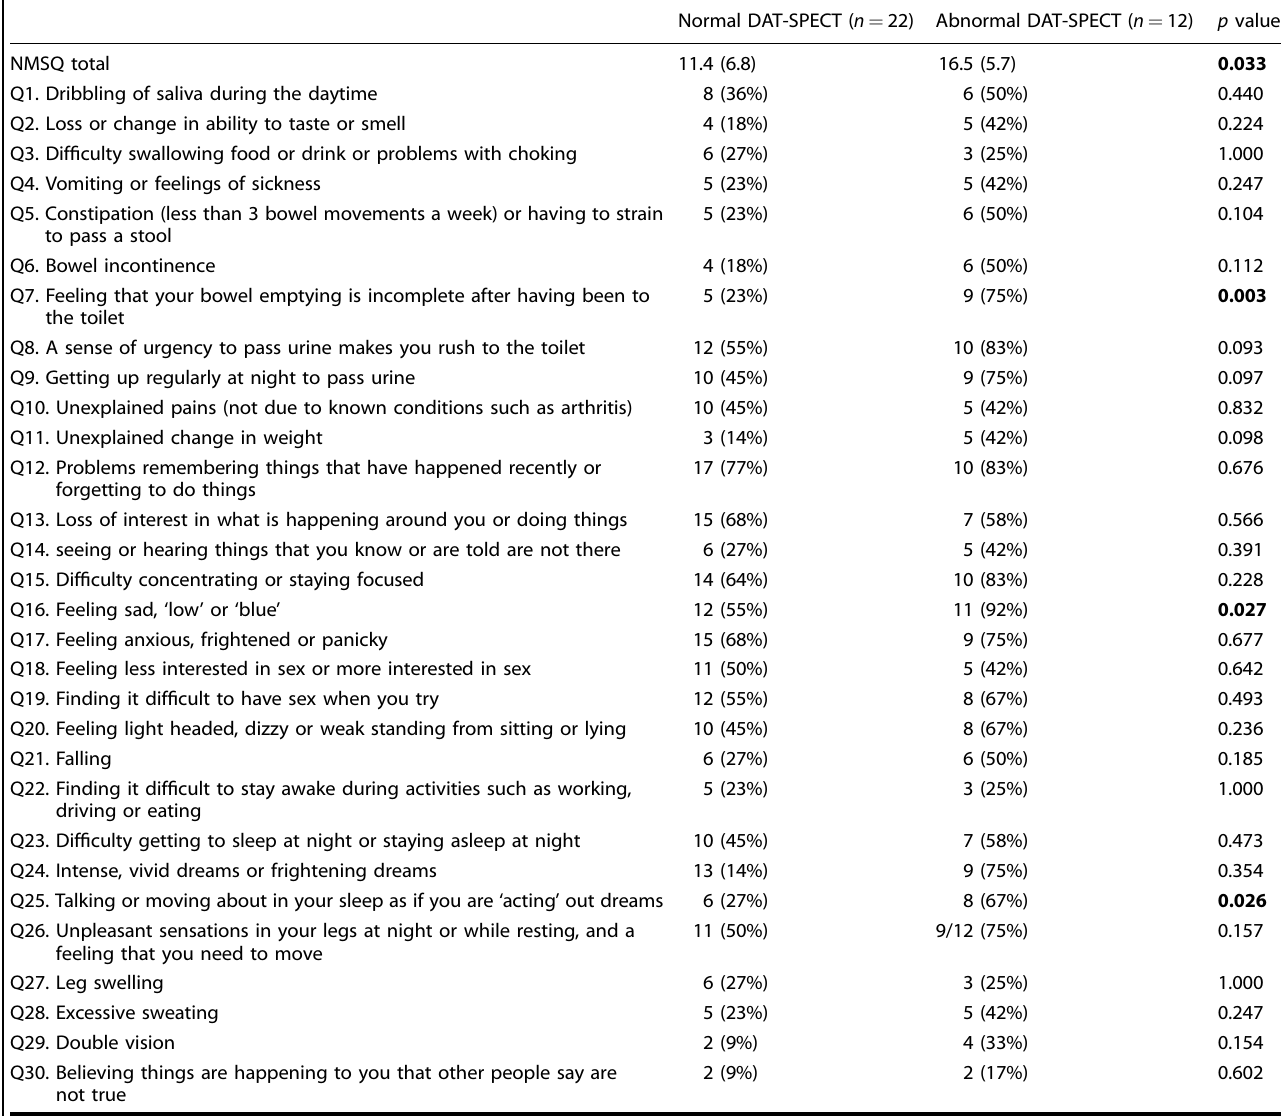
Table 3. Itemized NMSQ responses in DIP patients with normal and abnormal DAT ‐